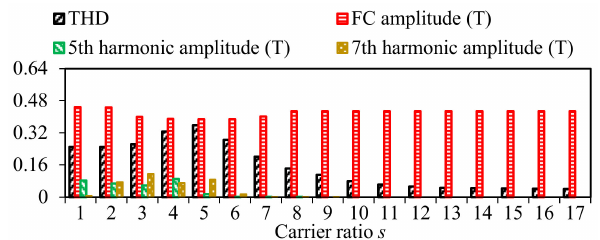
Figure 9. Features of B wu s m1 y versus the carrier ratio s for Array II.